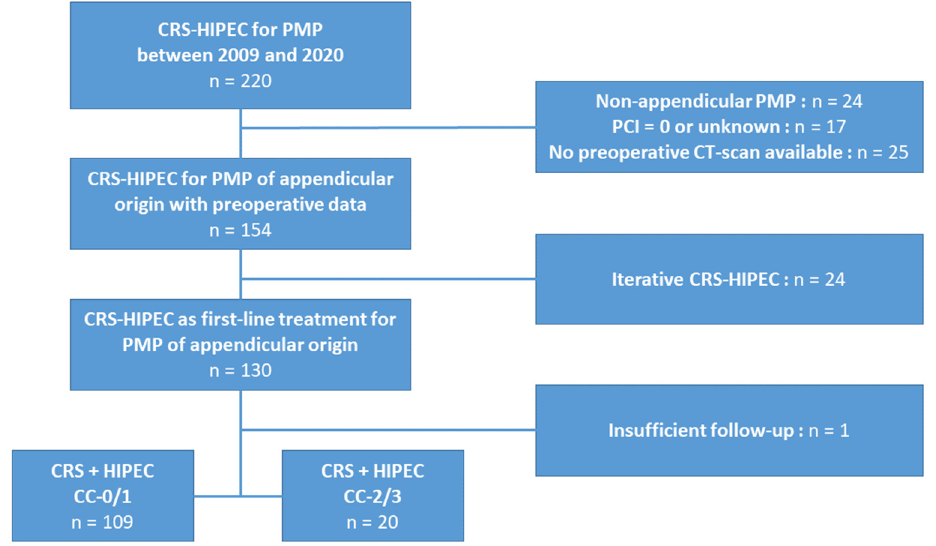
Figure 3. Study flowchart.